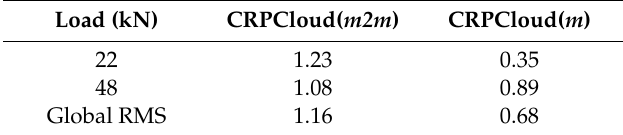
Table 16. RMS (mm) in the CRP-DPA comparison beam#1 LC2 EOS M3.